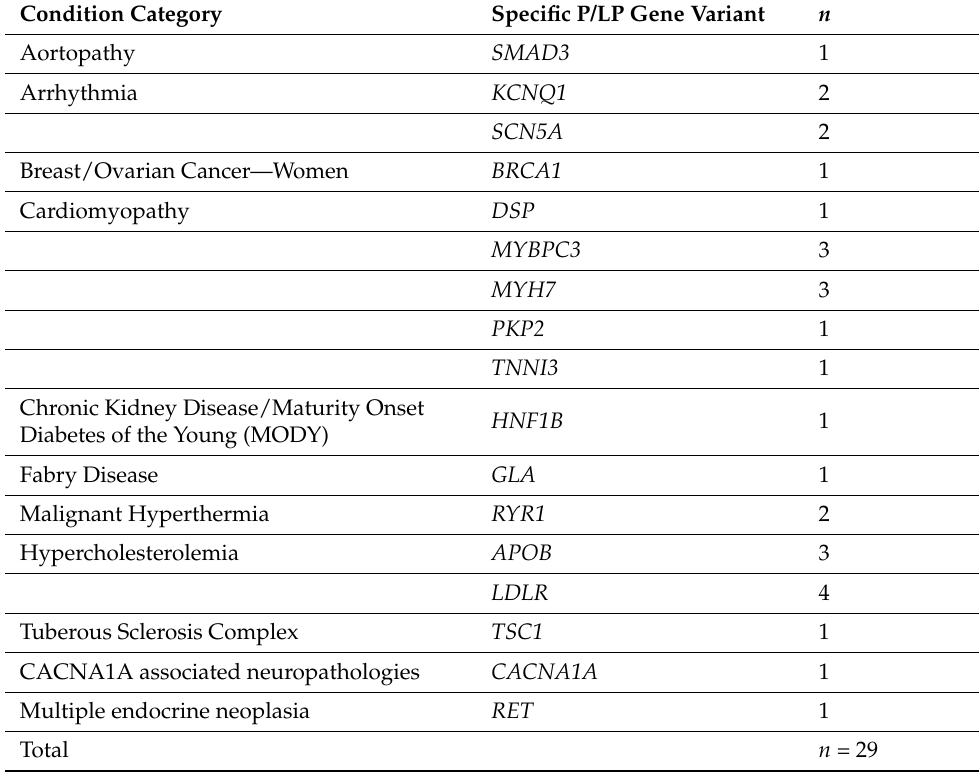
Table 1. Variants and Number Returned with Outcomes Forms Available.